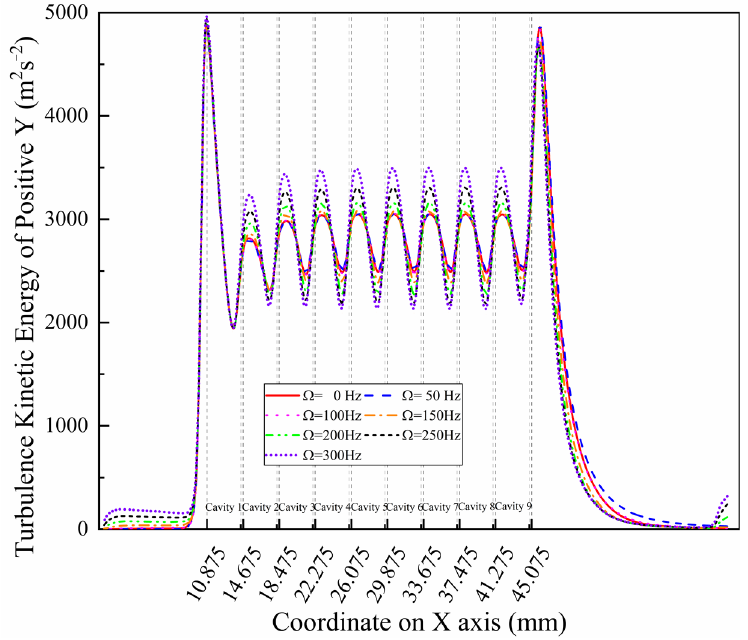
ω = 5000 rpm). Figure 17. Turbulence kinetic energy in the positive y-direction ( ω = 5000